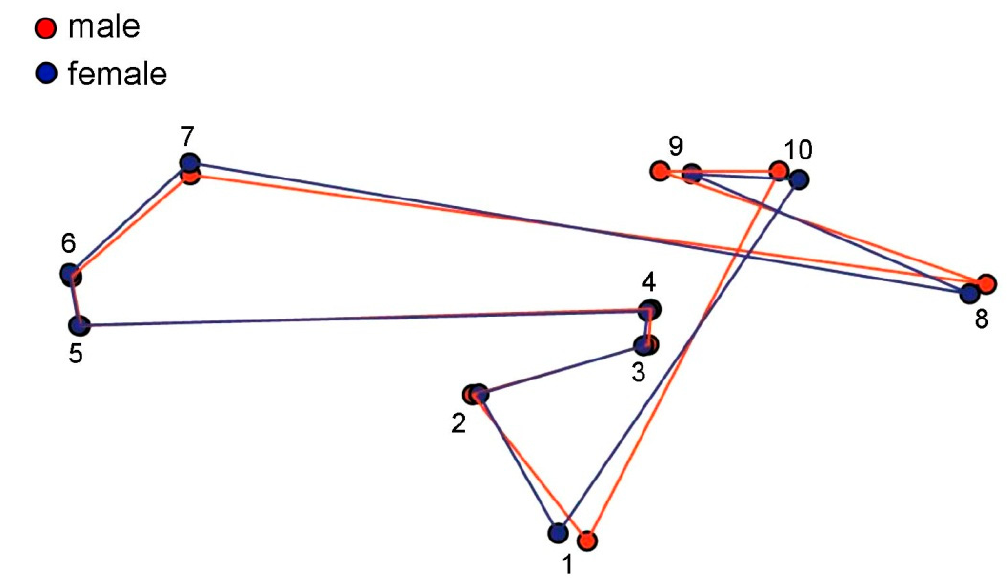
Figure 5. Configuration of the mean anatomical landmark positions connected by a straight line after Procrustes superimposition of Haematobosca aberrans Pont, Duvallet & Changbunjong, 2020 in both sexes.